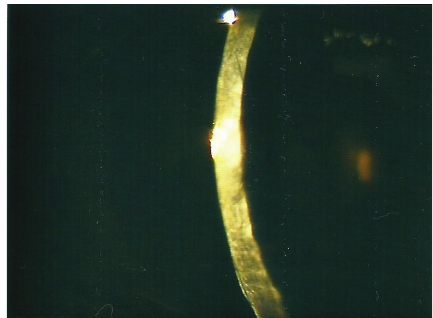
Figure 4: Well-opposed EK button and clear recipient